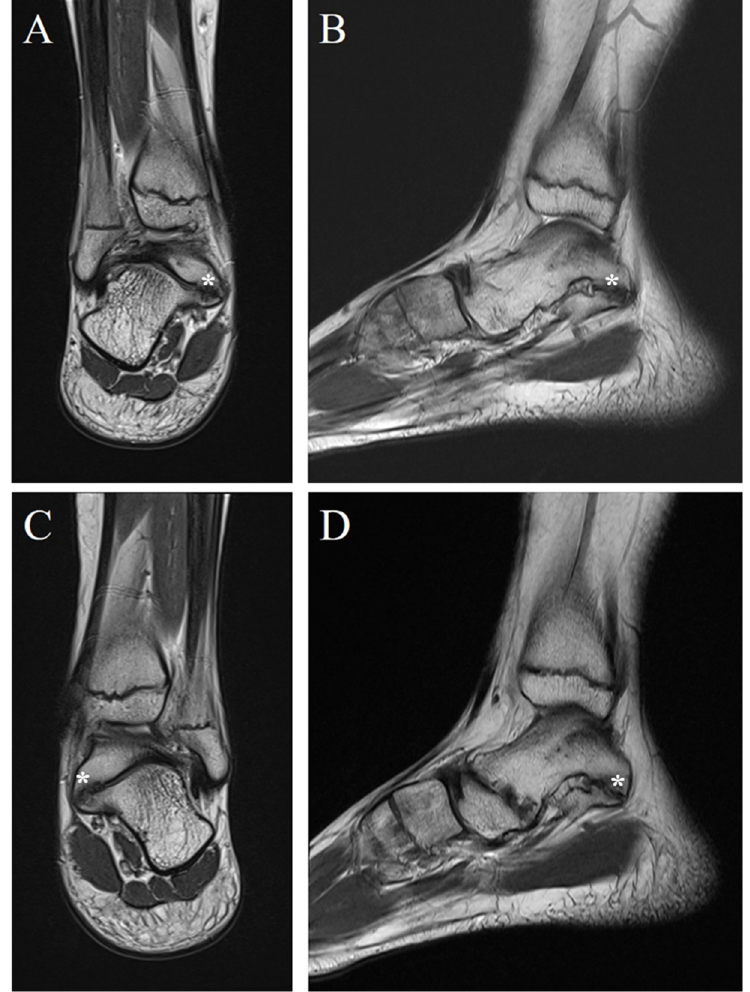
Figure 2. Coronal and sagittal images of magnetic resonance imaging (MRI) of both feet. ( A , B ) Coronal and sagittal MRI images of the right foot demonstrate fibrocartilaginous talocalcaneal coalitions at the posterior subtalar joint. ( C , D ) Coronal and sagittal MRI images of the left foot demonstrate fibrocartilaginous talocalcaneal coalitions (asterisk) at the posterior subtalar joint.